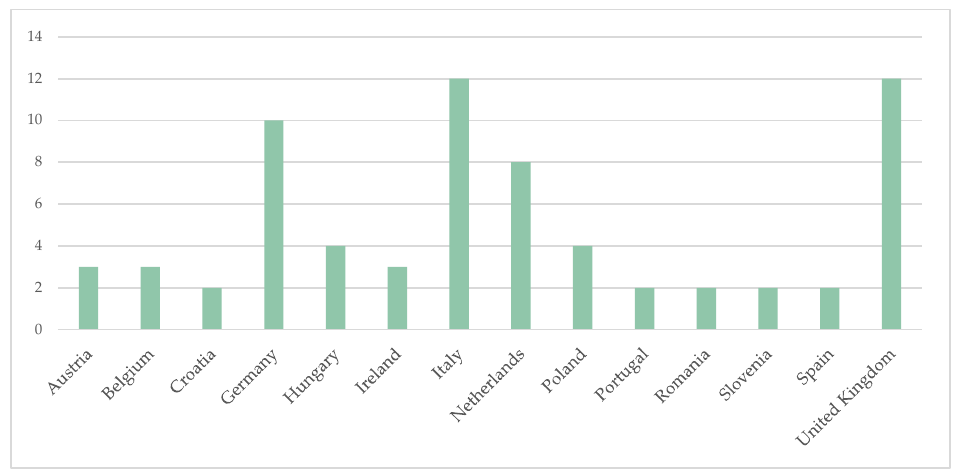
Figure 3. Number of NbS Projects by European countries.